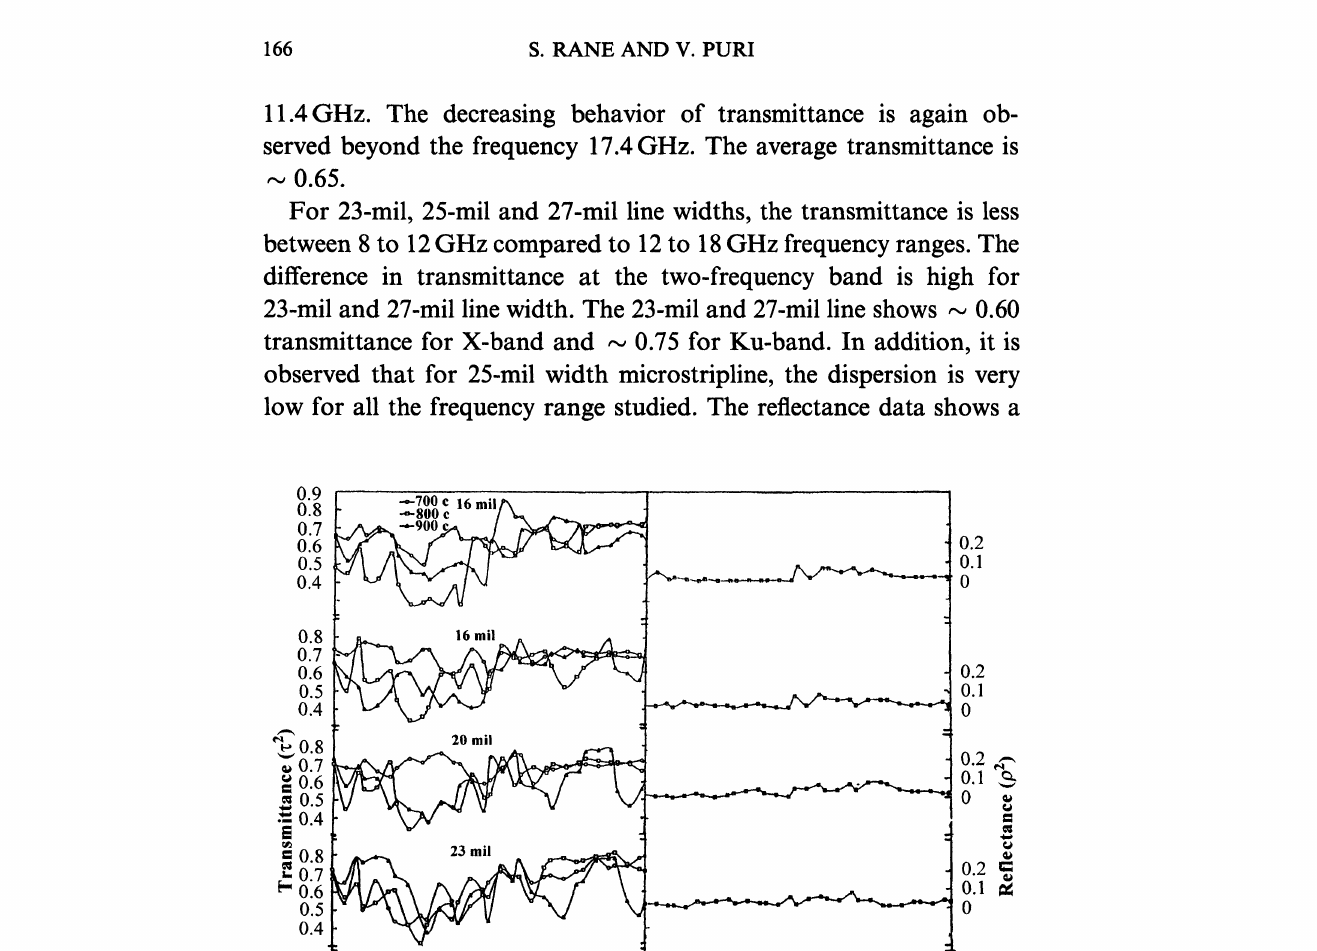
FIGURE 2 Microwave transmittance and reflectance of thick film microstriplines of different width and firing temperatures: (a) SBR3 paste, (b) SBR4 paste, (c) SBR5 paste, (d) SBR6 paste and (e) ESL